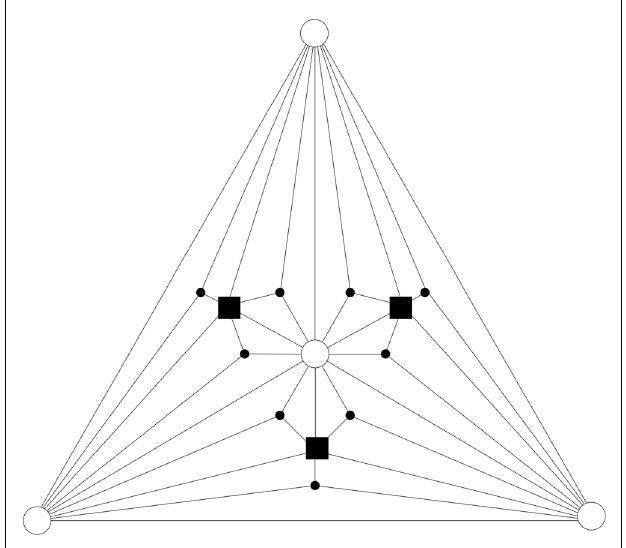
FIGURE 1 |Apollonian network for N = 2: iterations n = 0, 1, 2 are symbols (cid:2) , (cid:2) , • , respectively.